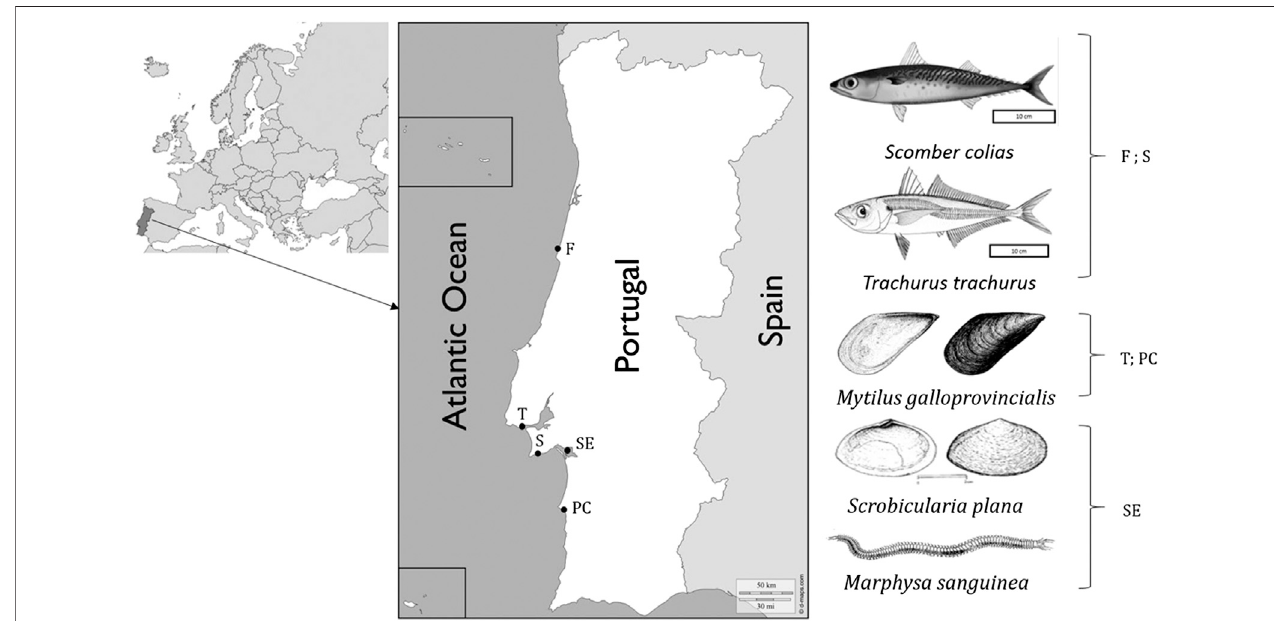
FIGURE1| SamplingsitesandthespeciescollectedalongthePortuguesecoast — F:FigueiradaFoz;T:TagusEstuary;S:Sesimbra;SE:SadoEstuary;PC:Porto Covo.